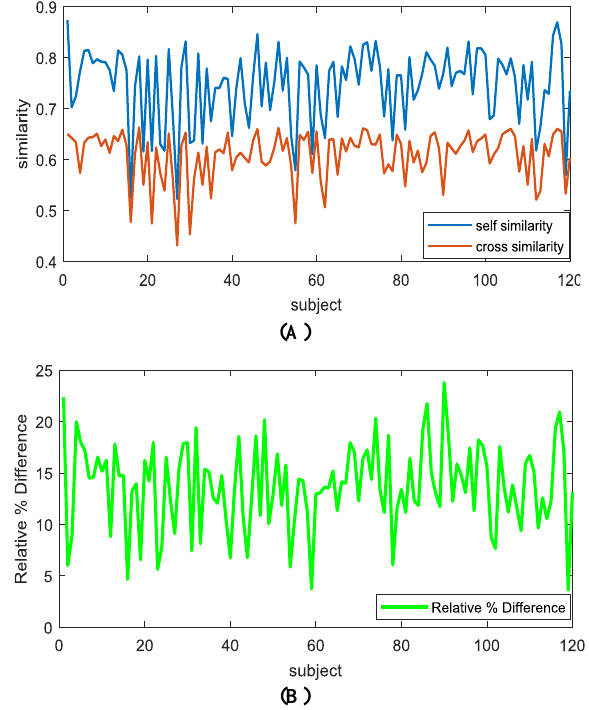
Figure 3. Self-similarity and cross-similarity (A) relative percentage differences (B) scores obtained across each